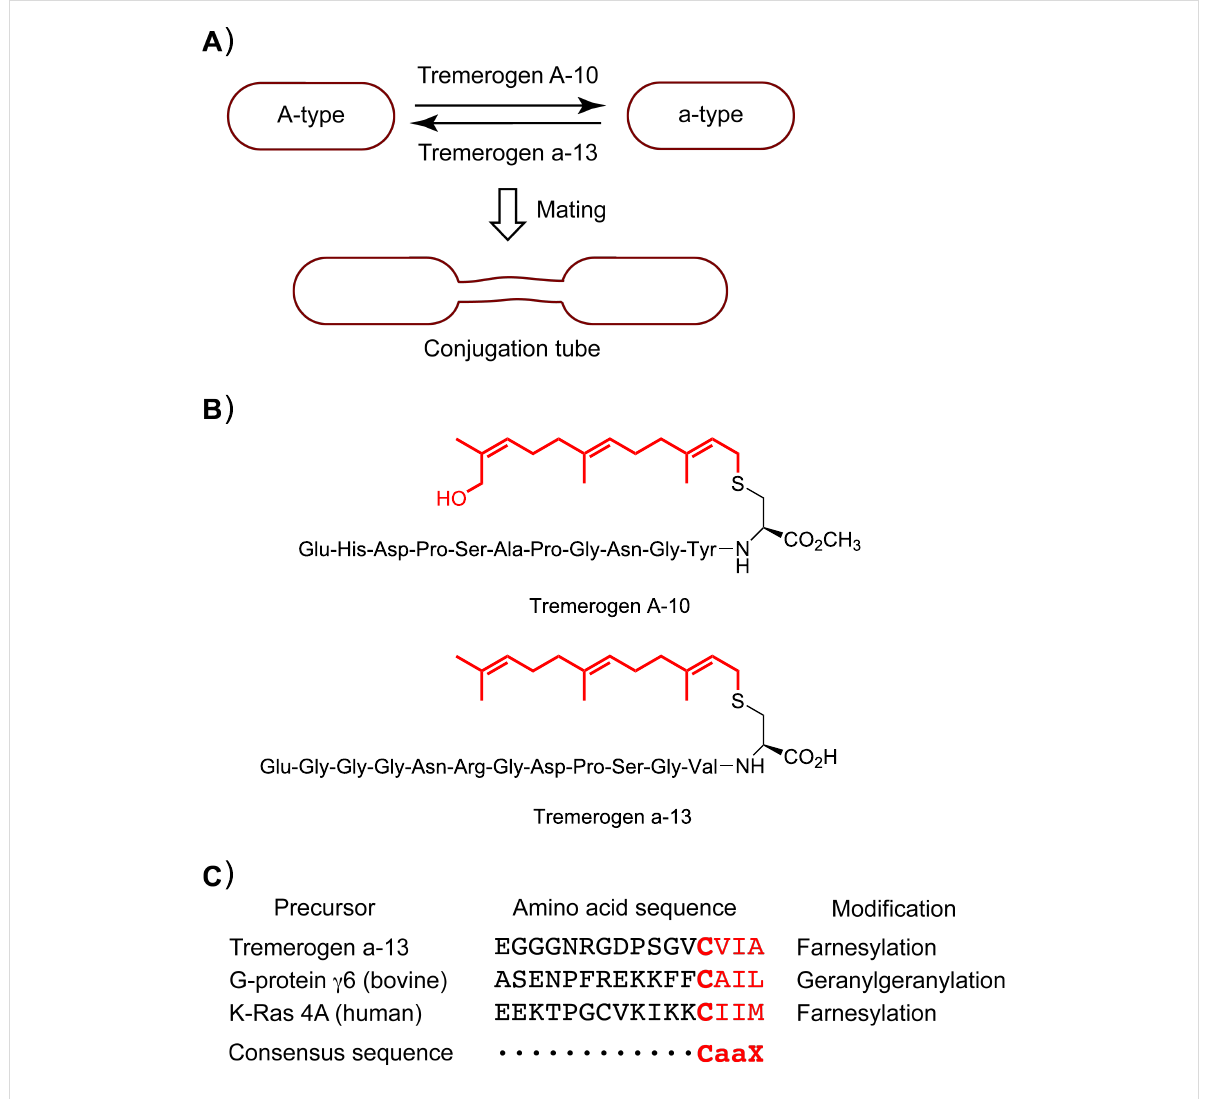
Figure 1: (A) Schematic representation of pheromone-induced conjugation tube formation for mating in Tremella mesenterica . (B) Chemical struc- tures of tremerogens A-10 and a-13. The isoprenyl side chains are shown in red. (C) C-terminal amino acid sequences of the precursors of isopreny- lated peptides and proteins. The CaaX motifs are shown in